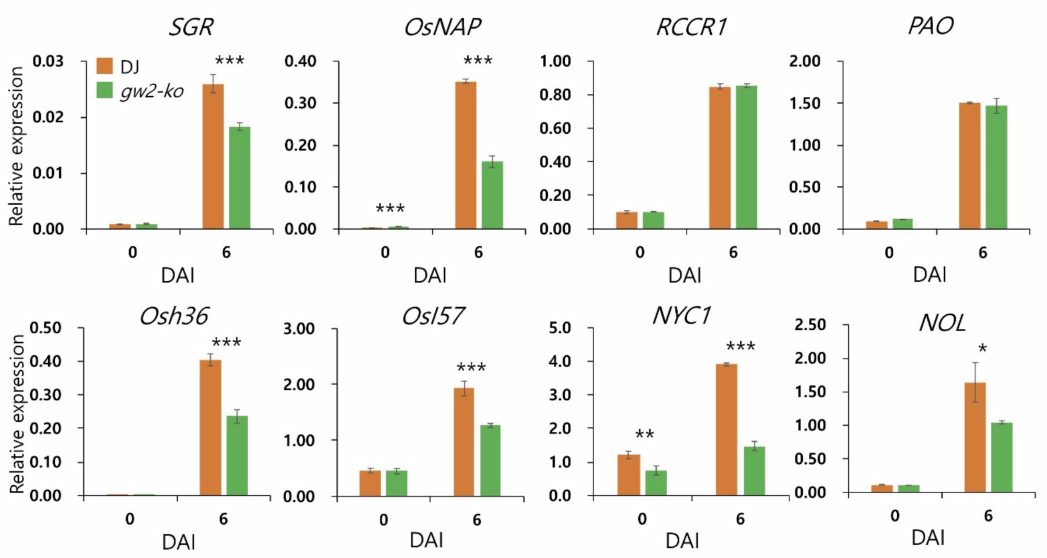
Figure 7. Expression of senescence-associated genes and chlorophyll degradation genes compared in Dongjin and gw2-ko . qRT-PCR was conducted to determine the transcript level of genes. OsUBQ5 was used for normalization. Error bars indicate the standard deviation of three replications. *, **, and *** indicate significant di ff erence at p < 0.05, p < 0.01, and p < 0.001 based on Student’s t -test, respectively. DAI: days after